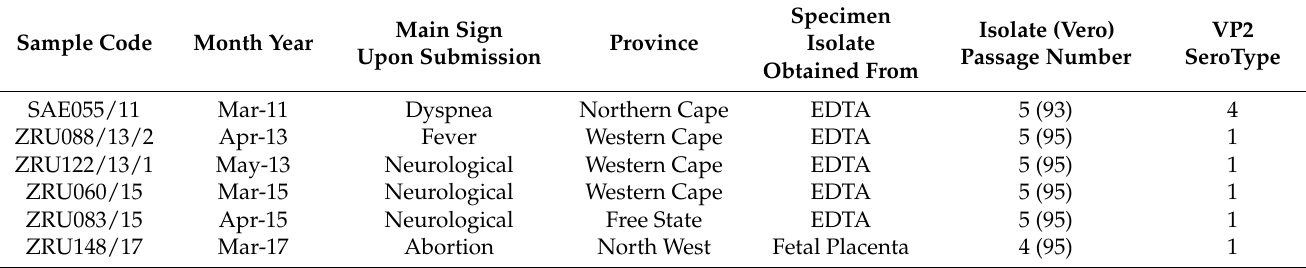
Figure 3. Maximum likelihood phylogram of the complete gene segment 2 of EEV (3206 nucleotides, taxa = 17, model: GTR+G, rooted at mid-point). Black circles indicate newly sequenced EEV isolates (Accession number: MN956740–MN956745), while white circles represent the reference strains. Clustering of all ten segments is indicated next to each sample. These are colored according to the reference serotype or field isolate group assigned with each segment. Table 2. Equine encephalosis virus isolates from which full gene segments were obtained indicating the submission date, associated clinical sign, location, and sample